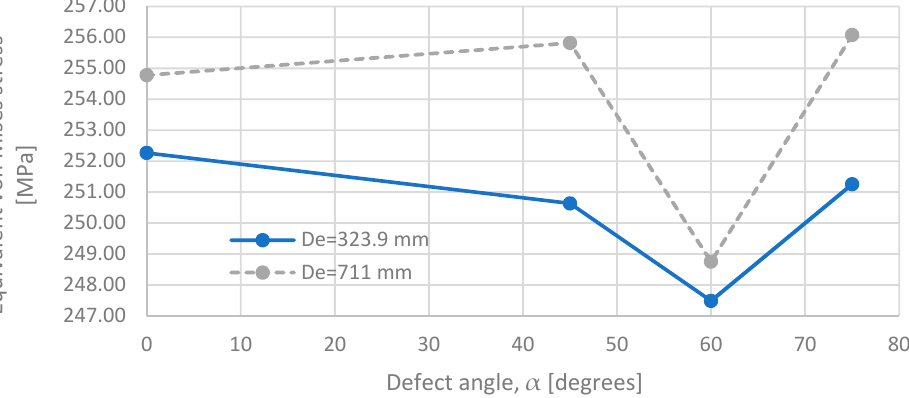
Figure 13. Equivalent von Mises stress maxima for 323.9 mm and 711 mm pipes, type II composite and the relative defect depth d rd = 0.3.